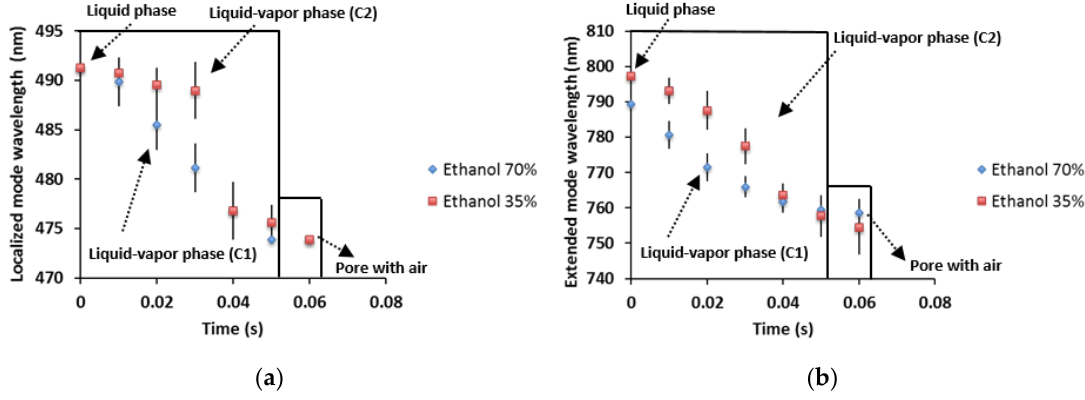
Figure 4. Comparison of liquid ethanol evaporation with concentrations of 70% and 35% in a localized mode and an extended mode as a function of time. ( a ) This figure shows the shift of the localized mode as a function of time by the ethanol evaporation for concentrations of 70% and 35%. ( b ) The shift of the extended mode towards its initial position as a function of the time by the phase change from liquid to vapor of ethanol at 70% and 35% concentrations.